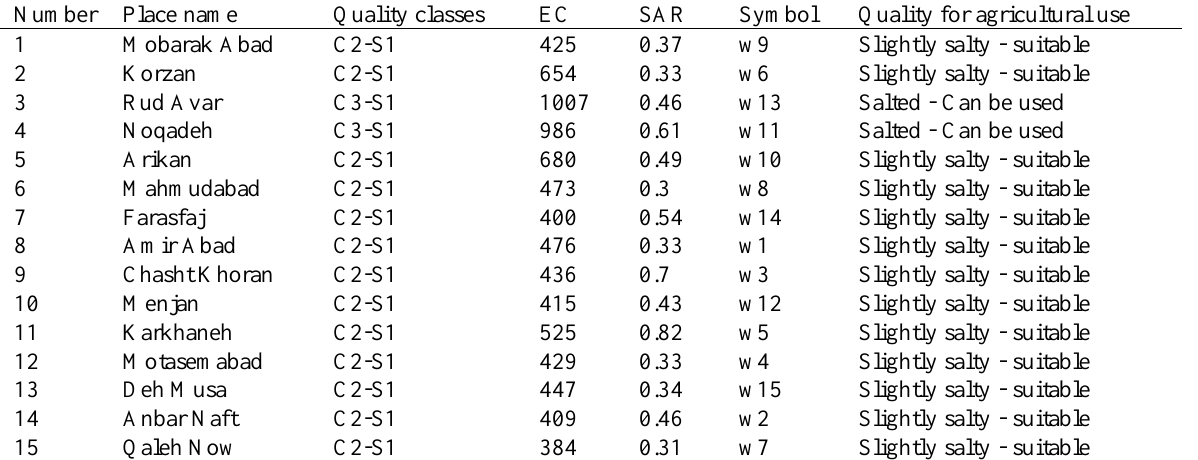
Table 4. Results of Wilcox diagram for each point of Tuyserkan plain